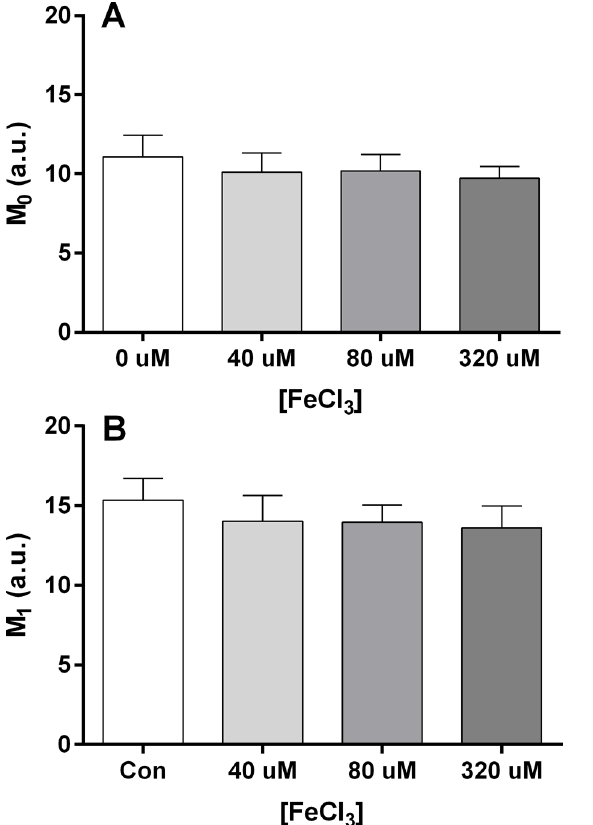
Fig 4. Aggregation of RBC suspensions in autologous plasma following incubation with various concentration of FeCl 3 . Incubation with FeCl 3 did not influence the RBC aggregation at stasis (M 0 ; Panel A) or at low-shear (M 1 ; Panel